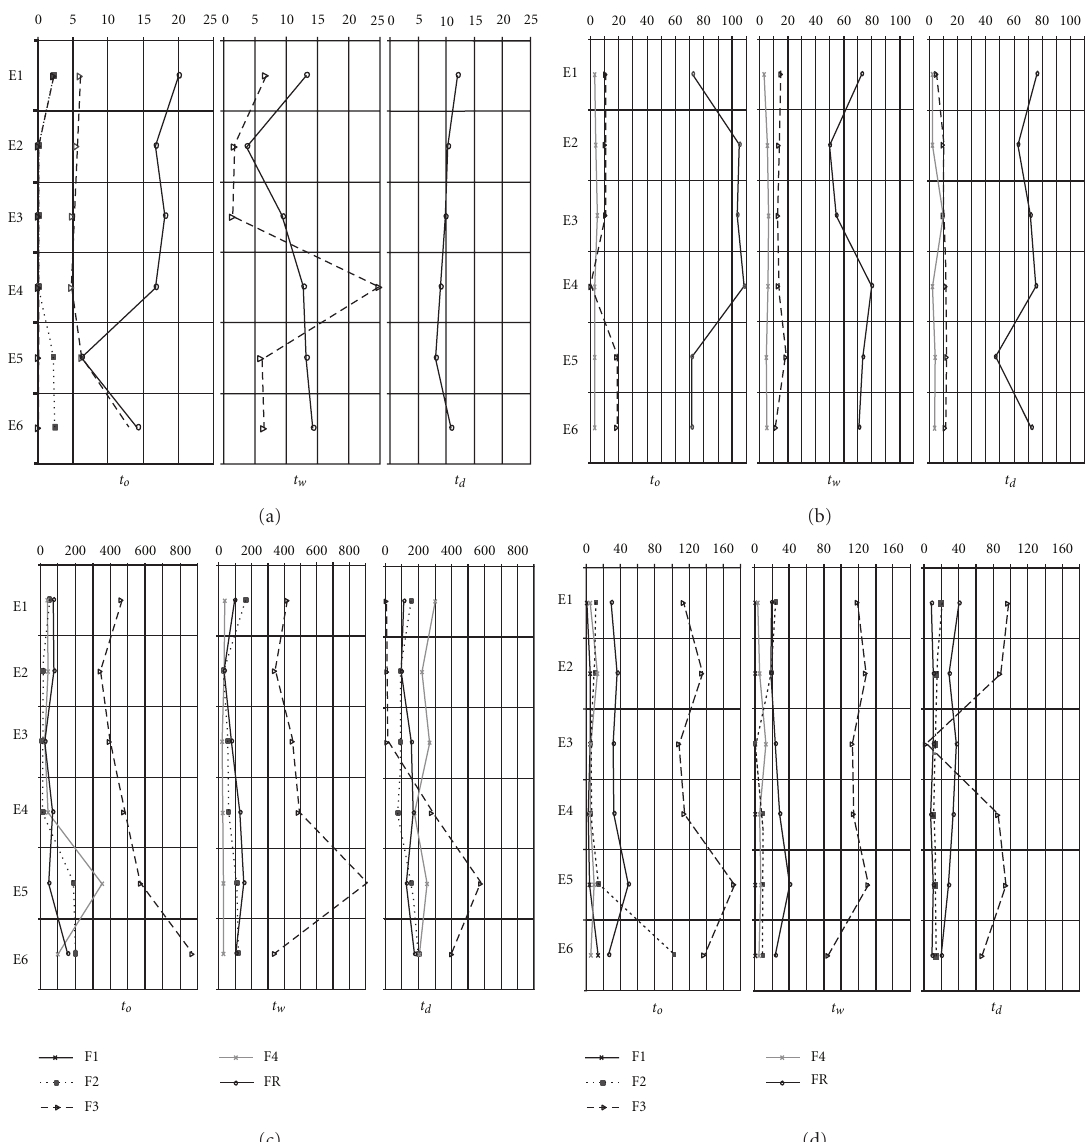
Figure 6: Absolute data for the concentration (mg · kg − 1 ) of the extracted Pb (a), Fe (b), Cu (c), and Zn (d) in the six strata of the selected profile from Pile 2 before the assay ( t 0 ) and after the wet ( t w ) and dry ( t d ) seasons. Data: average, n = 3.